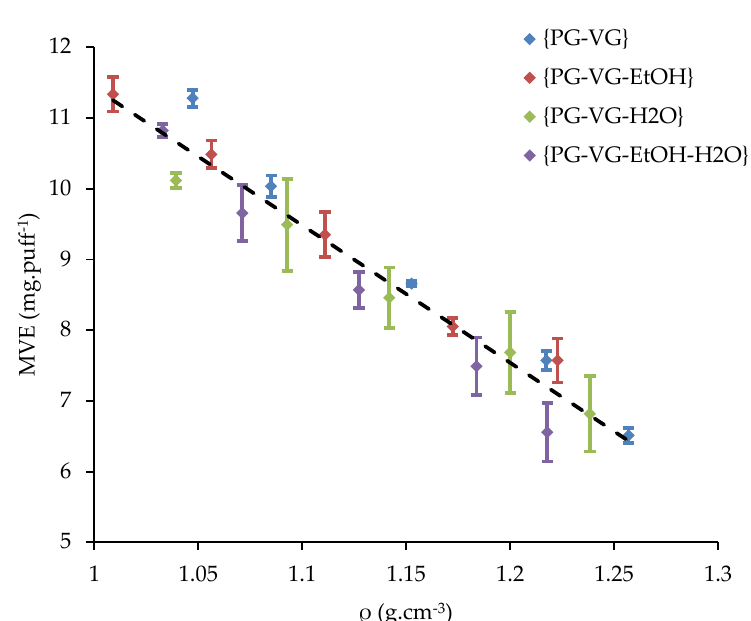
Figure 7. MVE—Influence of the density using {PG-VG}, {PG-VG-EtOH (10%)}, {PG-VG-H 2 O (10%)}, and {PG-VG-EtOH-H 2 O (5%–5%)} ranges.